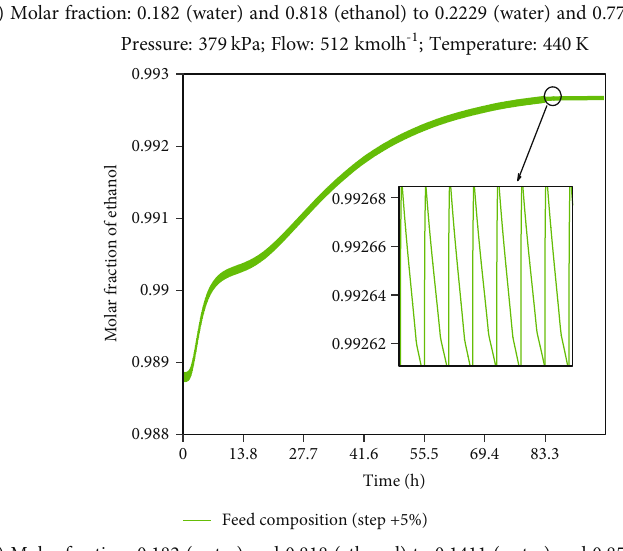
Figure 5: Sensitivity analysis applied to the PSA process for the production of bioethanol